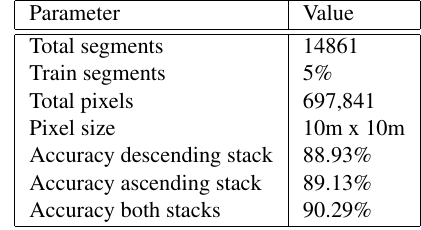
Table 1: Classification summary and performances